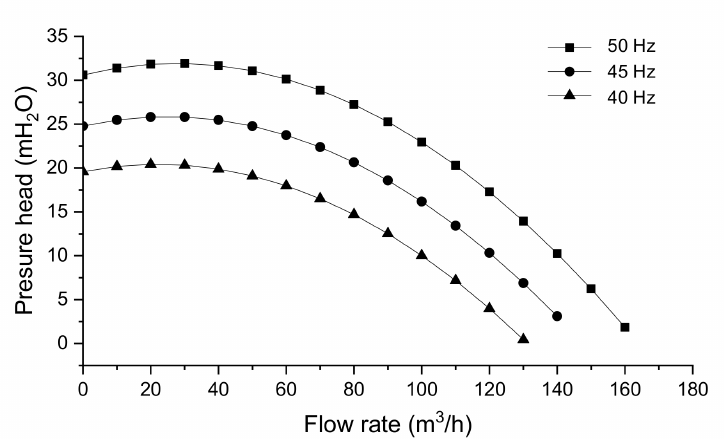
Figure 7. The hydraulic characteristic curves of the primary pump.